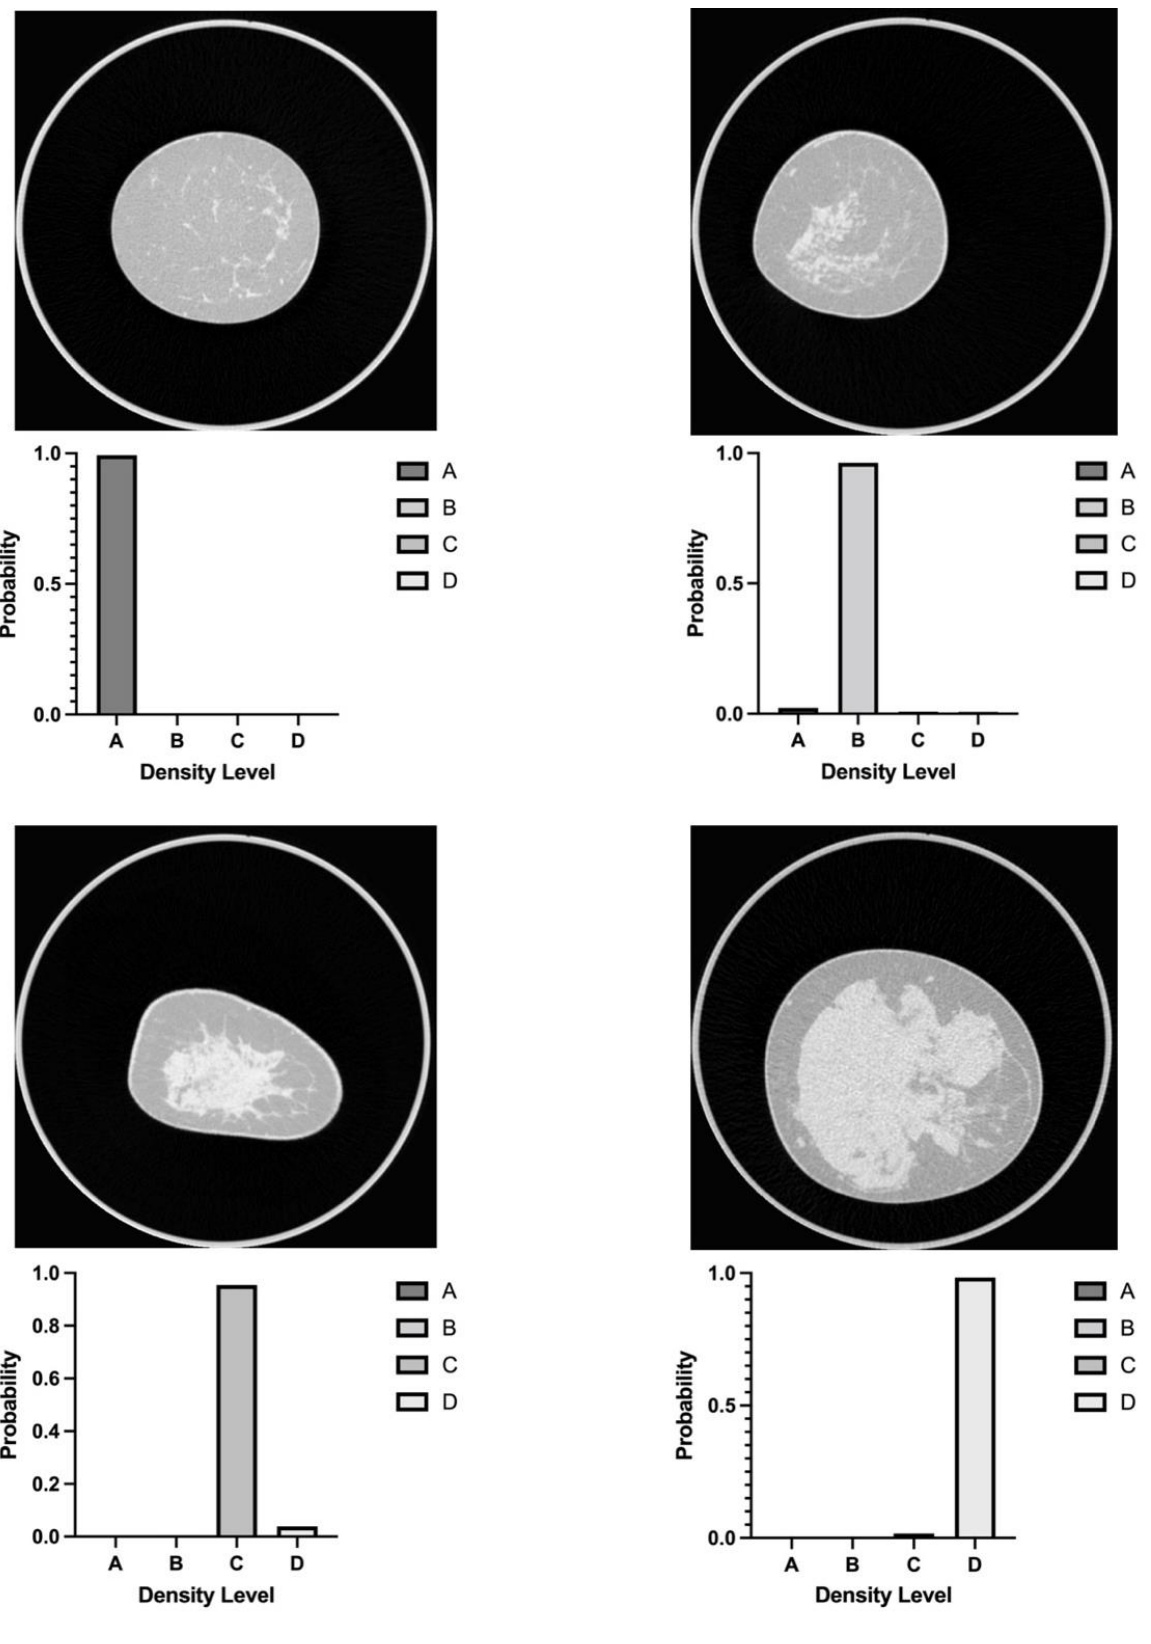
Figure 3. Example dCNN evaluations for breast-CT images showing different density levels, one example for each category.